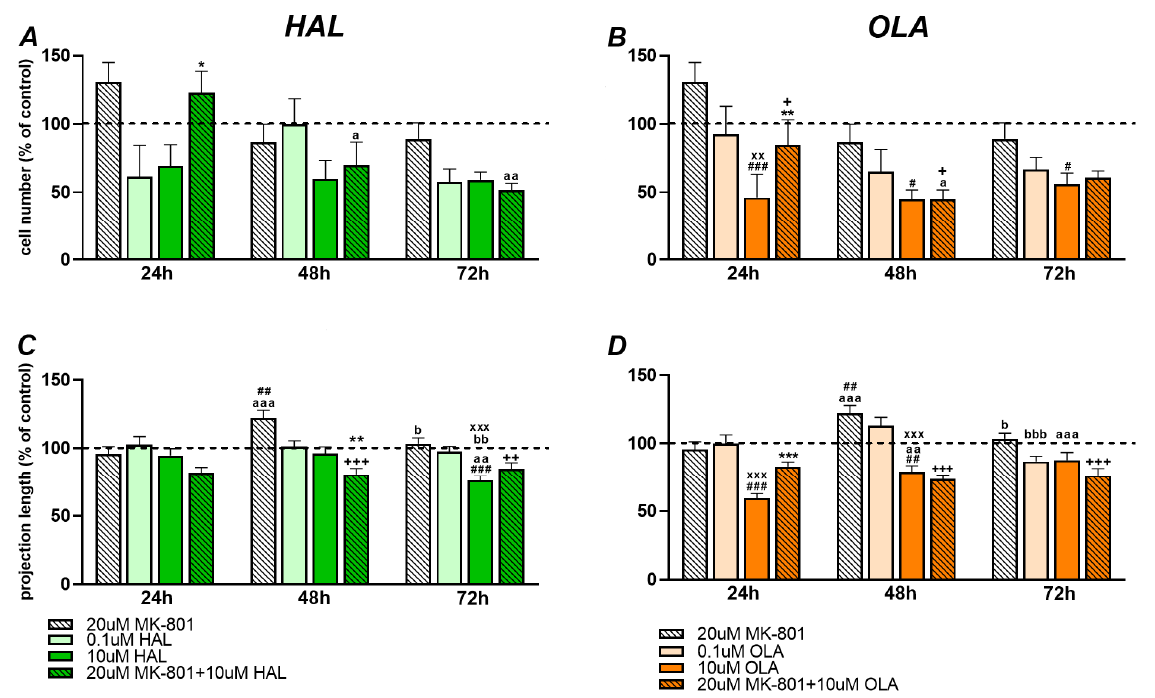
Figure 1. Cell number ( A , B ) and length of cells’ projection ( C , D ) after 20 µM MK-801, 0.1 and 10 µM HAL/OLA treatment, and 20 µM MK-801 + 10 µM HAL/OLA co-treatment after 24 h, 48 h, and 72 h. Data are expressed as percentage compared to controls that represent 100% (dotted line in graphs). # p < 0.05 vs. control, ## p < 0.01 vs. control, ### p < 0.001 vs. control, * p < 0.05 vs. 10 µM